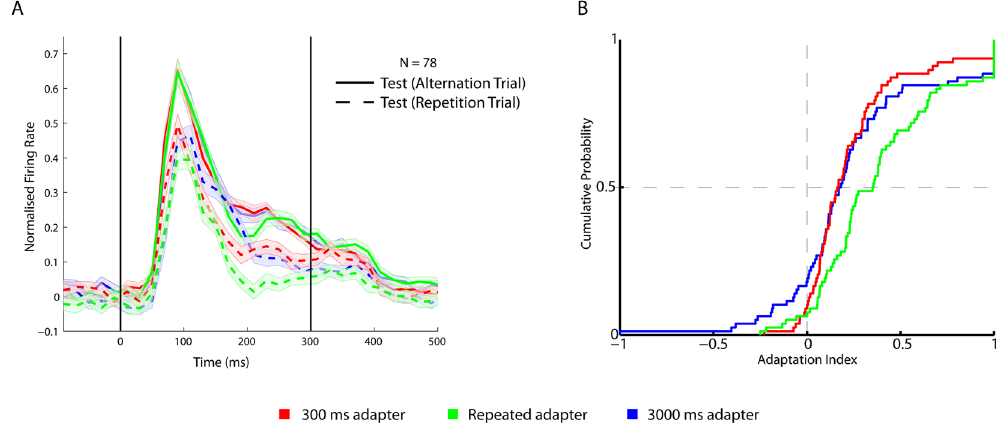
Figure 3. Responses following short, long and repeated adapter. ( A ) Normalized net firing rate to test stimuli following a 300 ms, 3000 ms and the repeated adapter in repetition and alternation trials. The firing rates for single units and multi-unit sites were averaged. Same conventions as in Fig. 2. ( B ) Cumulative distributions of the adaptation contrast indices for the 300 ms adapter duration, 3000ms adapter duration and repeated adapter